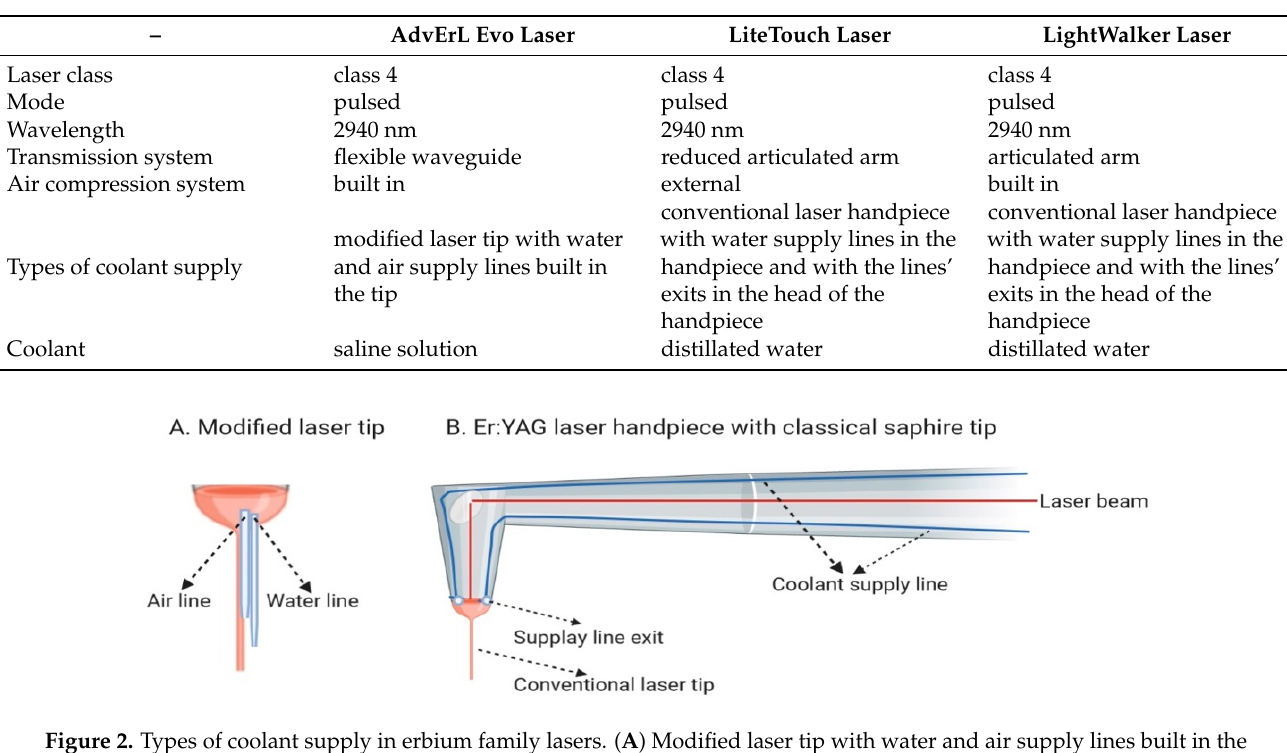
Table 1. The characteristic of three common erbium lasers used in dentistry and compared in the study.